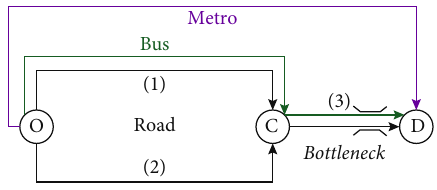
Figure 10: A network with three travel